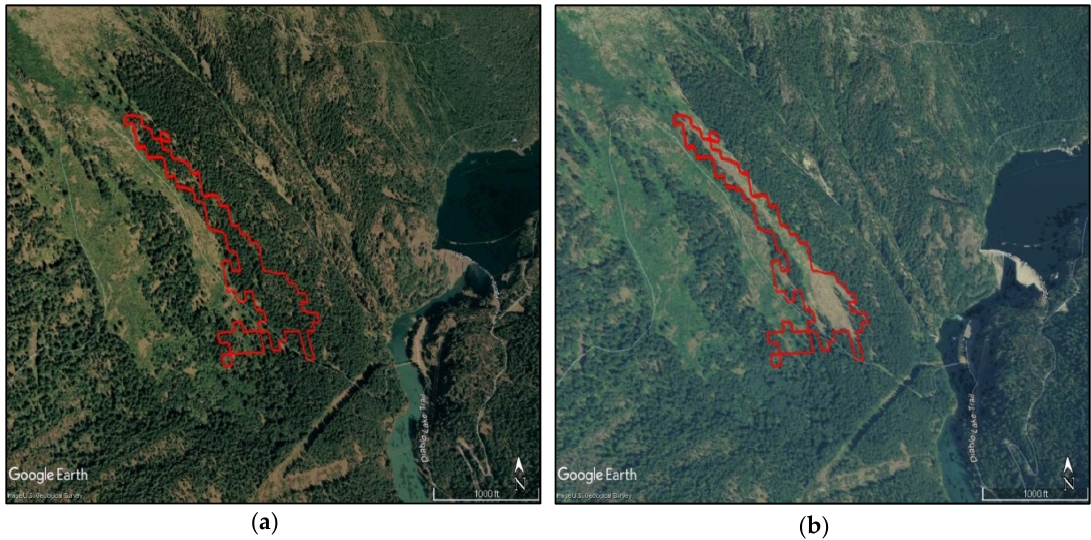
Figure 2. ( a ) 2006 Google Earth™ aerial photo used to view pre-disturbance land cover during office validation of a landscape change patch. ( b ) 2009 Google Earth™ aerial photo used to view post-disturbance land cover of the same patch.